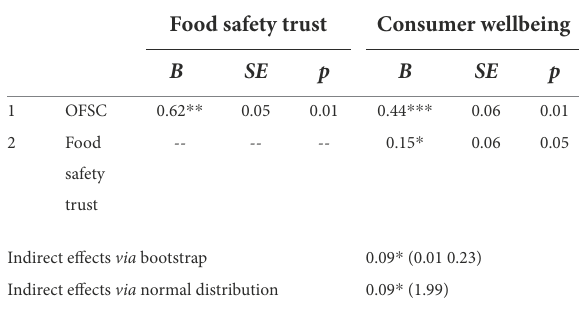
TABLE 4 Mediation